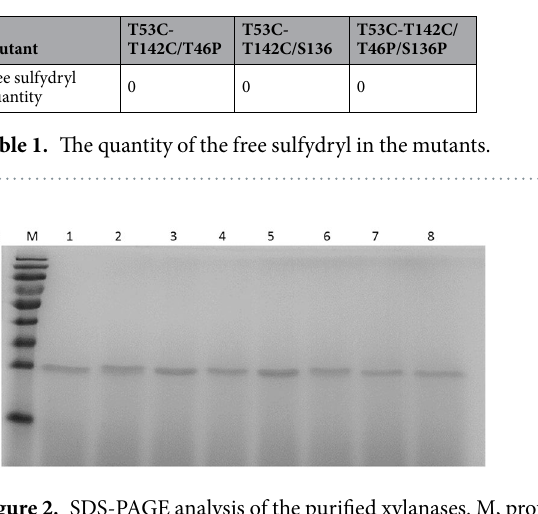
Figure 2. SDS-PAGE analysis of the purified xylanases. M, protein standard; lanes 1–8, wild-type xylanase, T53C-T142C, T46P, S136P, T53C-T142C/T46P, T53C-T142C/S136P, T46P-S136P and T53C-T142C/T46P/ S136P.